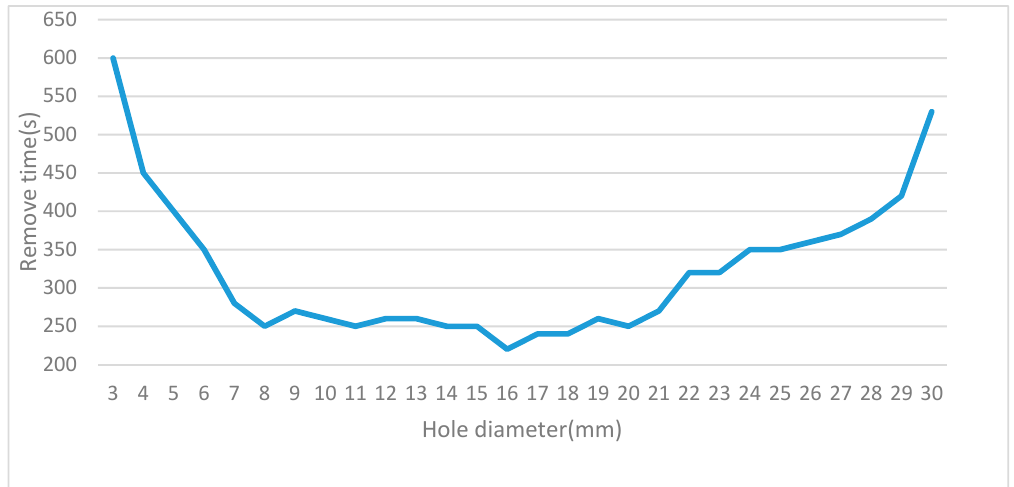
Figure 16. Effect of hole size on support removal time.